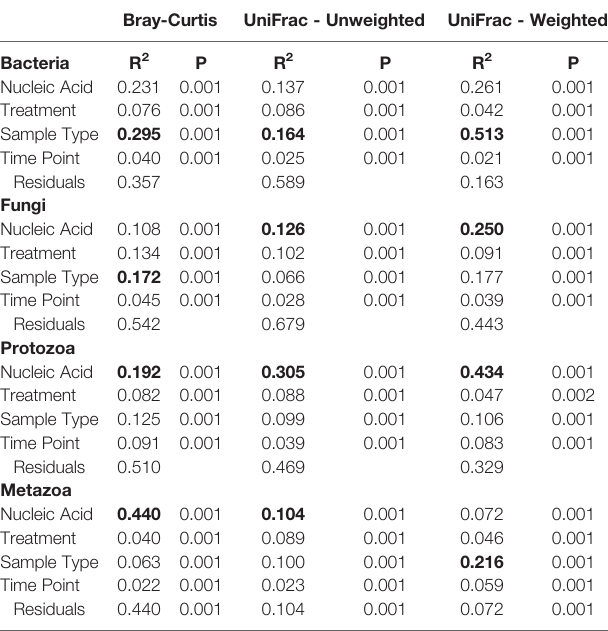
TABLE 1 | The impact of four variables on four organismal groups in fi elds with three soil management regimes with pea as main crop. Bray-Curtis UniFrac - Unweighted UniFrac - Weighted Bacteria